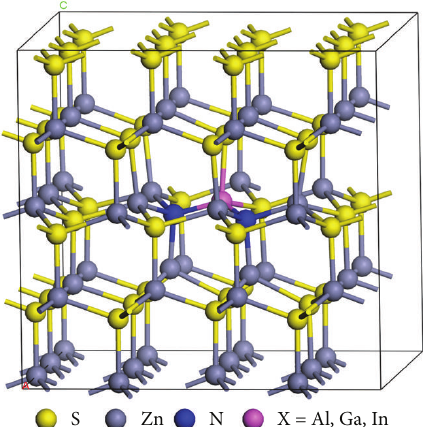
Figure 1: Schematic structure of codoping with N and X (Al, Ga, and In) in wurtzite ZnS.